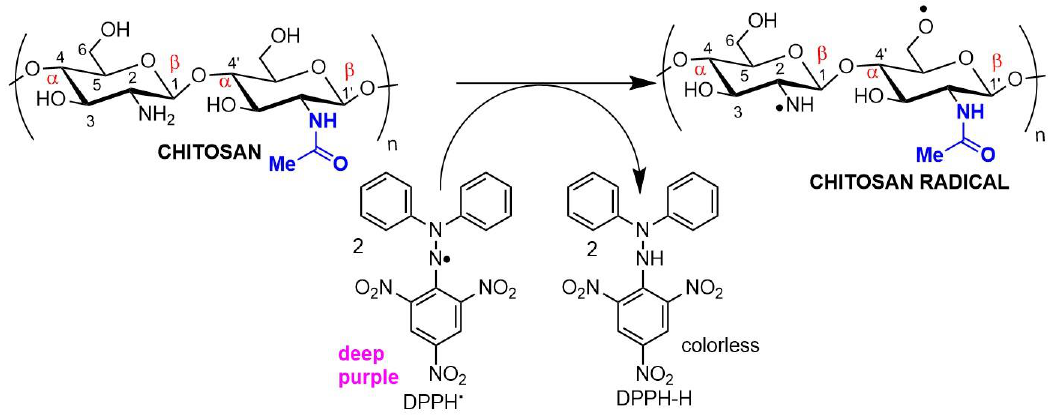
Figure 3. Chitosan radical scavenger activity demonstrated in an antioxidant assay using DPPH (2,2-diphenyl-1-picrylhydrazyl) as the electron acceptor. (2,2-diphenyl-1-picrylhydrazyl) as the electron